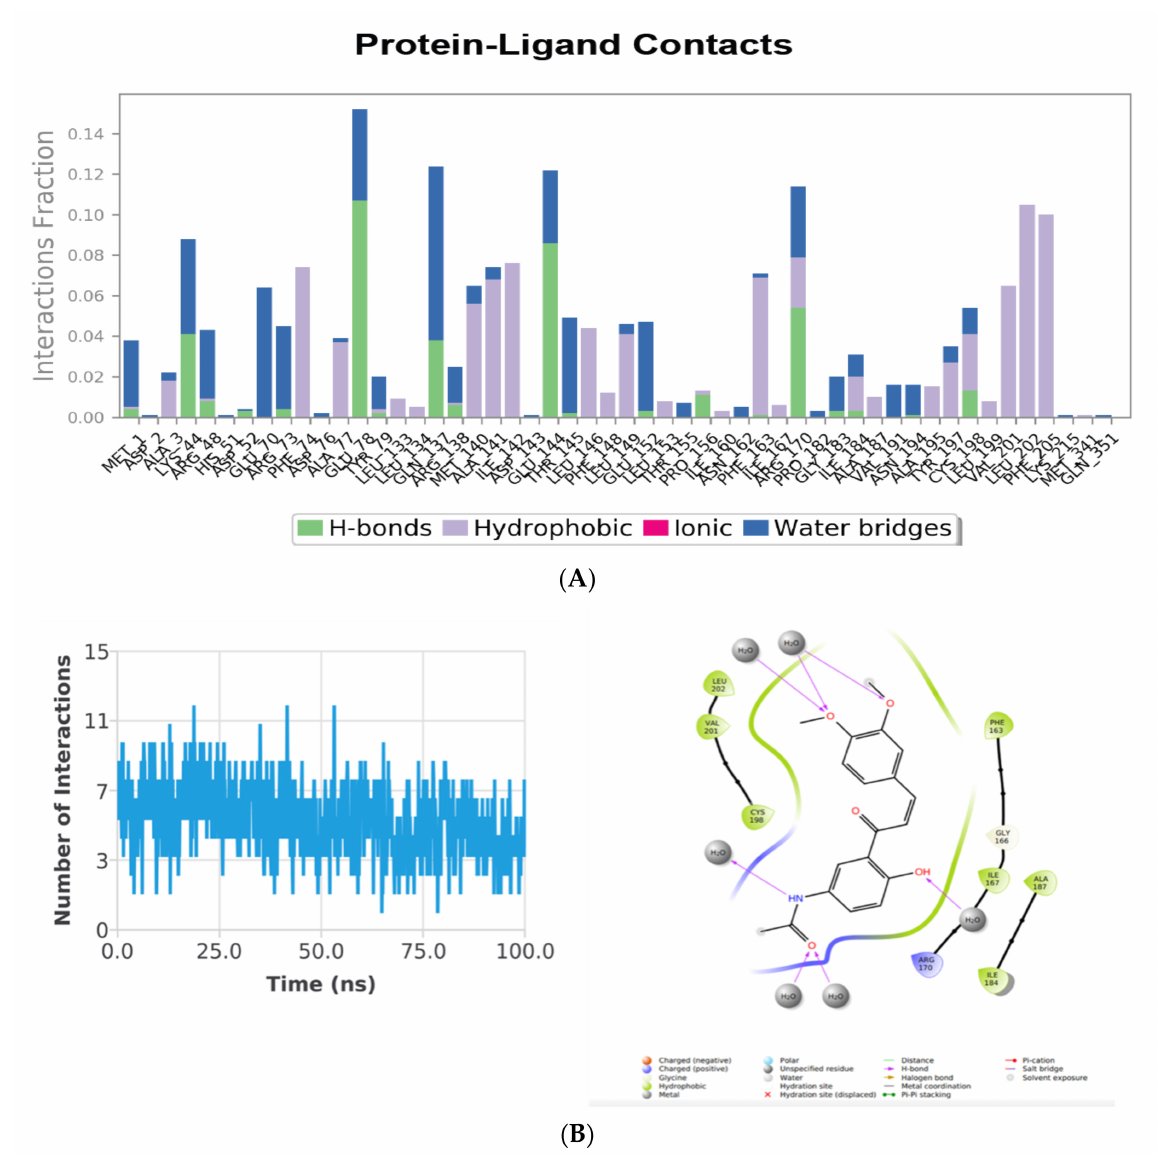
Figure 10. ( A ) Protein ligand contacts plot for heterodimeric PhcR–ZINC000011865192 receptor complex throughout the simulation. ( B ) Blue lines display H-bonds deviation observed in interaction during 100 ns simulation in Holo state. Post-MD simulations intermolecular H-bonding, electrostatic, and hydrophobic contacts made between PhcR–ZINC000011865192 complex. The image was drawn by Plot and the ligand interaction module of